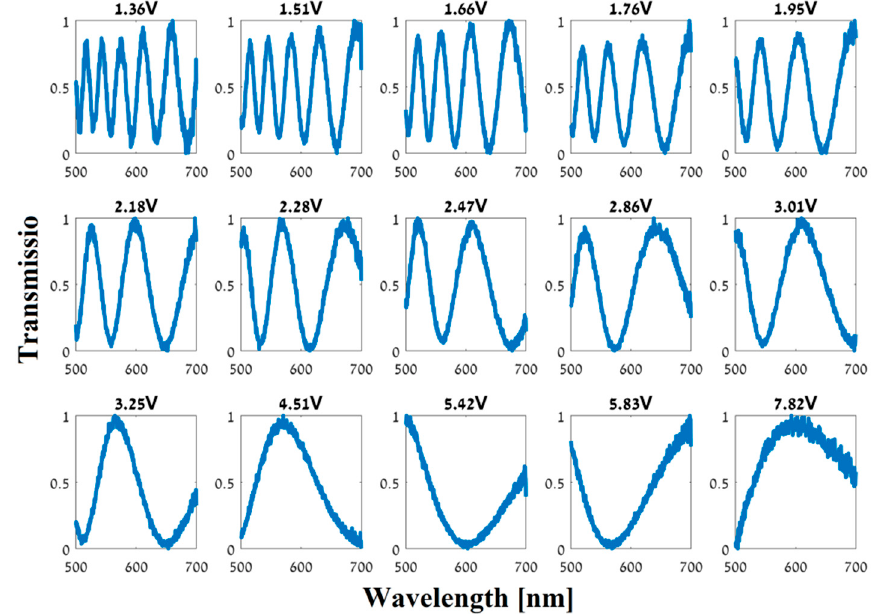
Figure 3. Measured spectral responses (intensity transmission vs. wavelength in nm) of the fabricated LC phase retarder. Each graph represents the spectral modulation with a different voltage applied on the LC cell (15 different voltages).